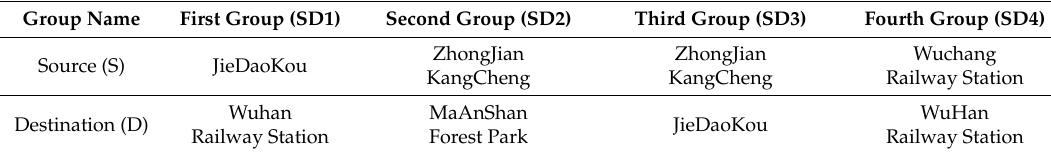
Table 2. Geographic names of four source–destination group.